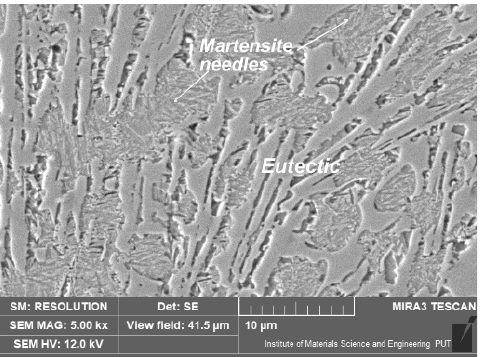
Figure 15. Microstructure of nodular cast iron surface layer, after laser alloying with titanium (etched with nital 3%).